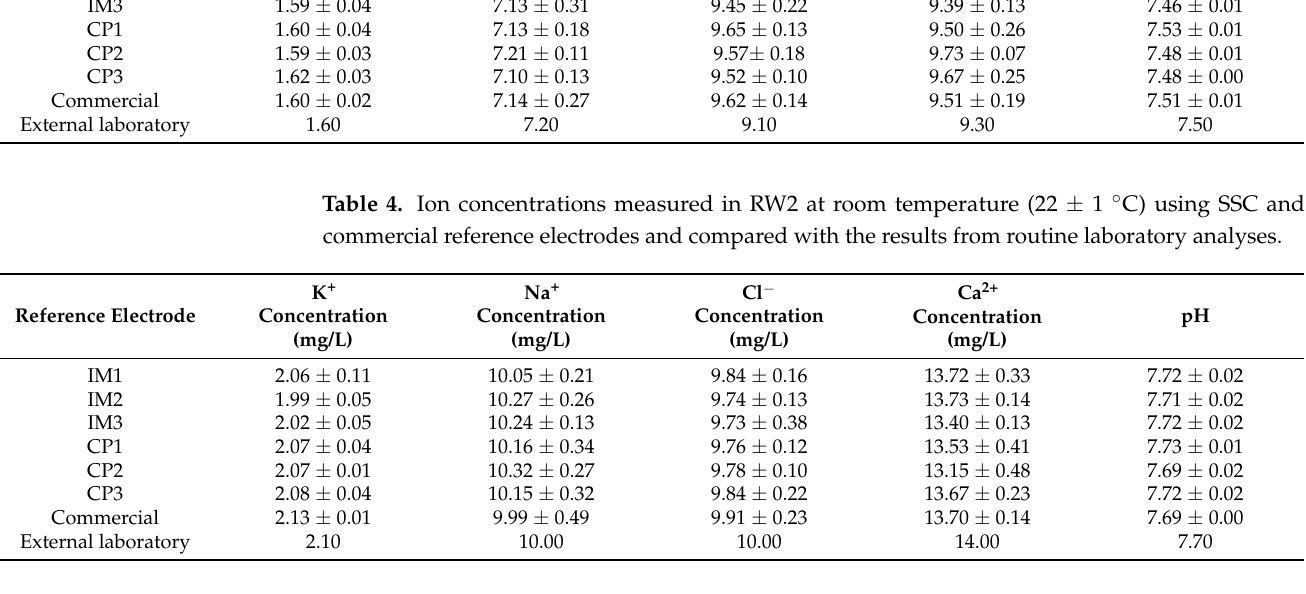
The results from similar analyses performed at 5 ◦ C are shown in Tables 5 and 6 below. Table 5. Ion concentrations measured in RW1 at 5 ◦ C using SSC and commercial reference electrodes and compared with the results from routine laboratory analyses measured at room temperature.